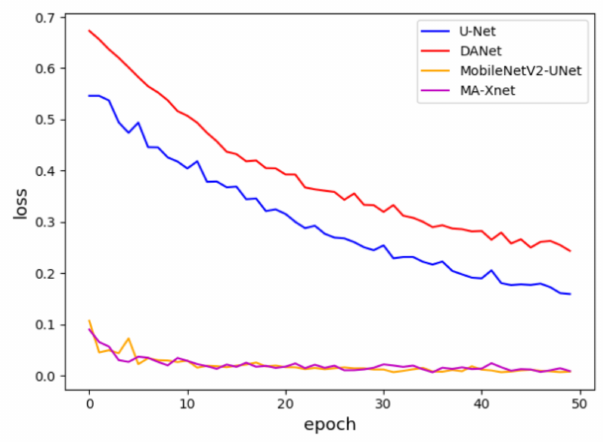
Figure 7. Loss function curve